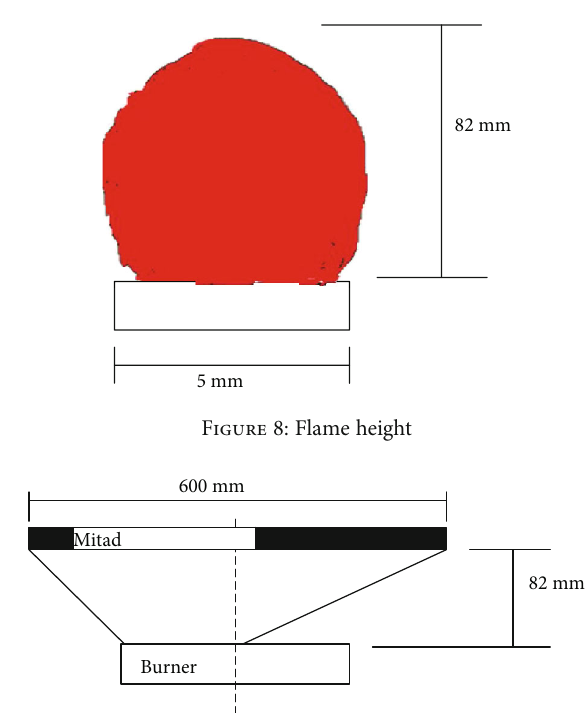
Figure 9: Heat transfer between burner and mitad by Figure 9. The temperature inside the baking room is 35 ° C